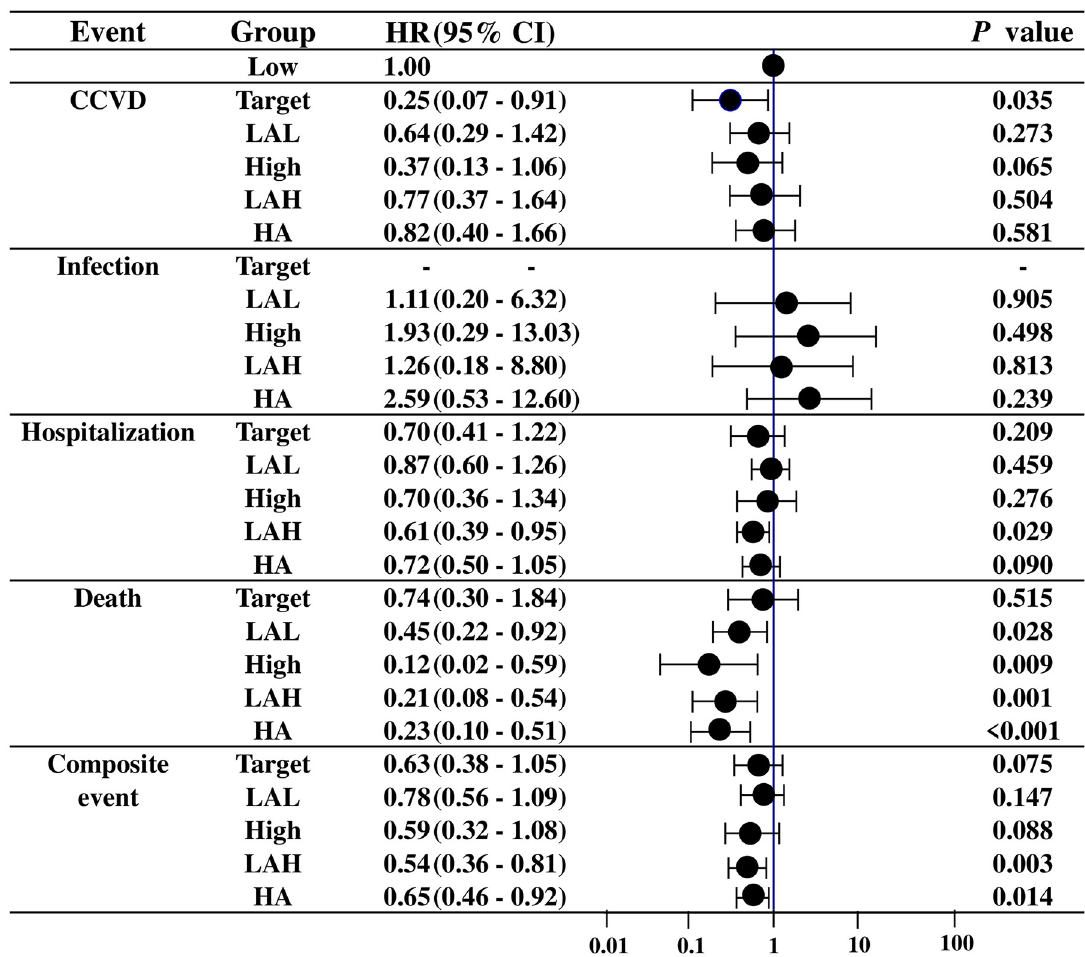
Fig 2. The relationship between TSAT levels and adverse events in MHD patients. Target: within the target TSAT range (20–30%). L: Low: consistently below the target TSAT range. LAL: Low-amplitude fluctuation around the lower limit of the target TSAT range. H, High: consistently above the target TSAT range. LAH, LAH-TSAT group: low-amplitude fluctuation around the upper limit of the target TSAT range. H, HA: high-amplitude fluctuation across the target-TSAT range. CCVD: cerebrovascular and cardiovascular disease. Composite events: CCVD, infection, hospitalization, and death.